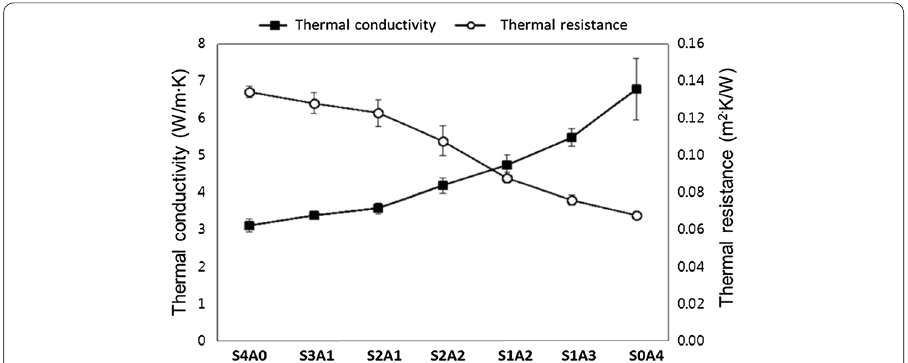
Fig. 9 Thermal conductivity and resistance of PS/PA6 blend